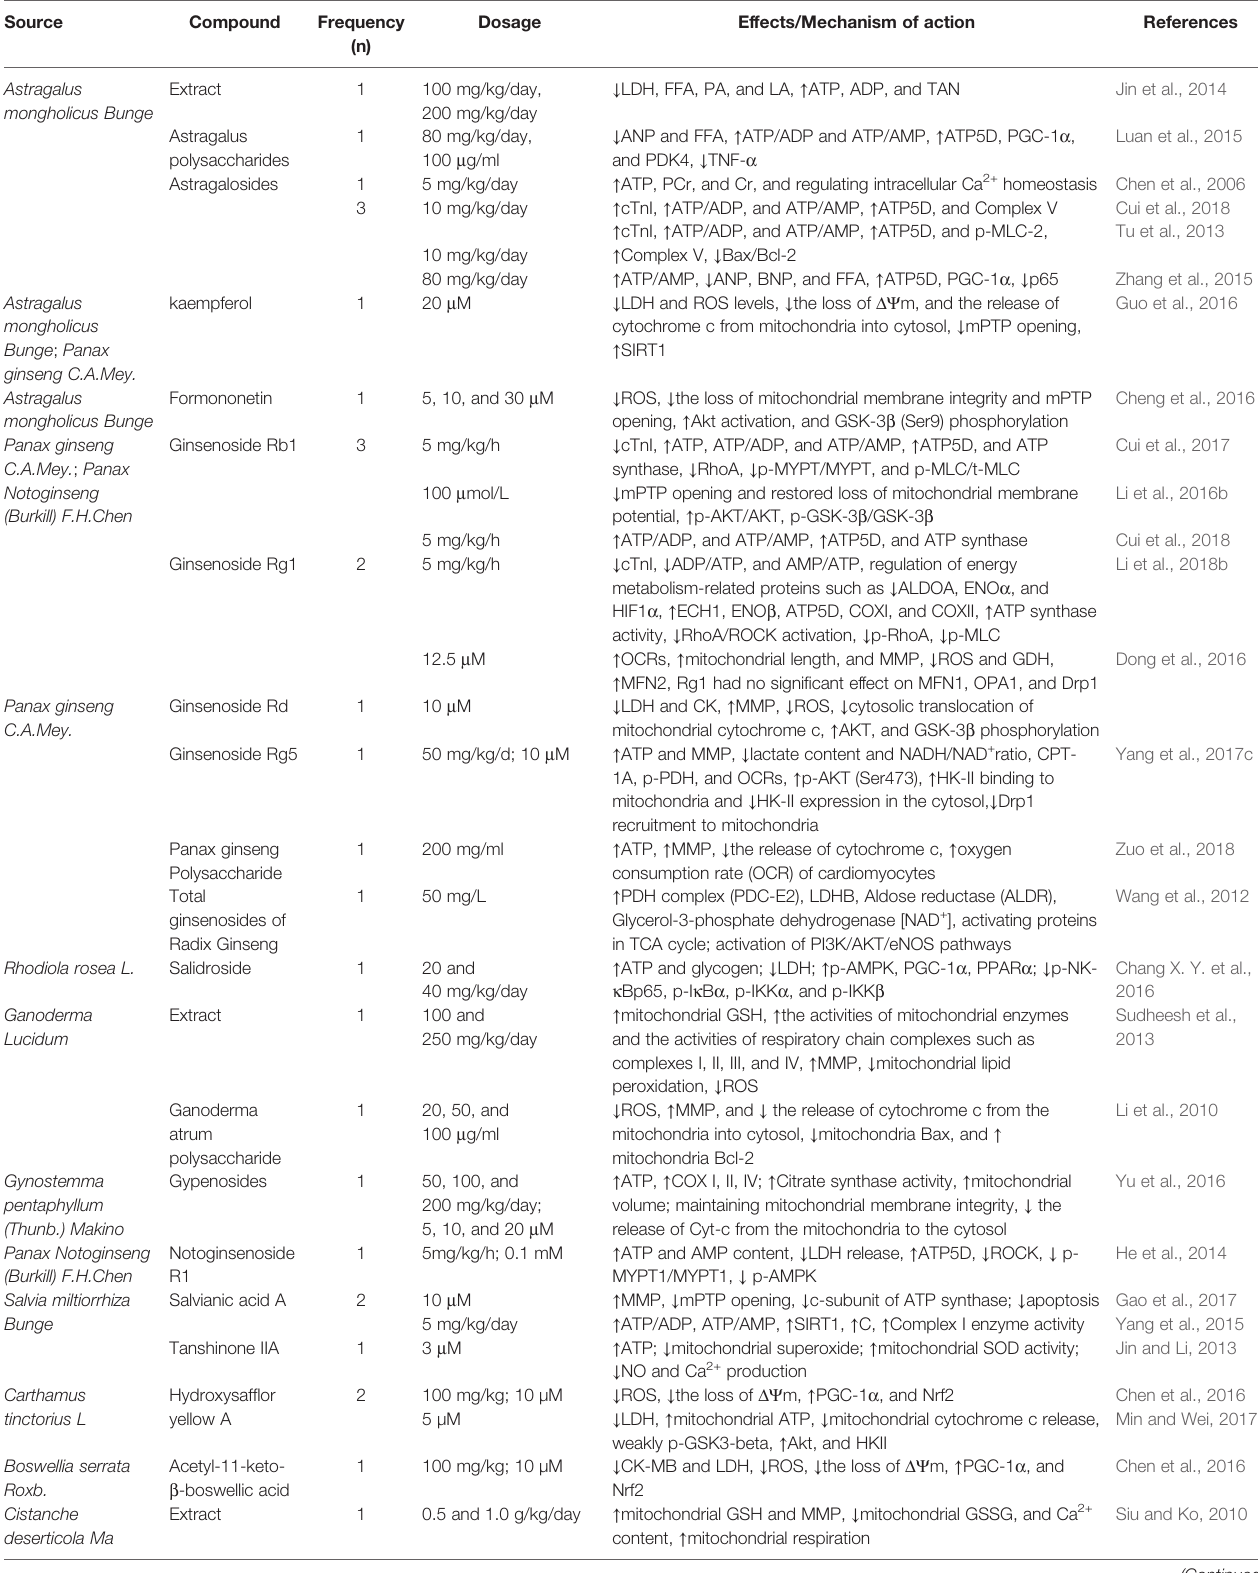
TABLE 1 | Metabolic effect and mechanism of CHMs and the major bioactive component in